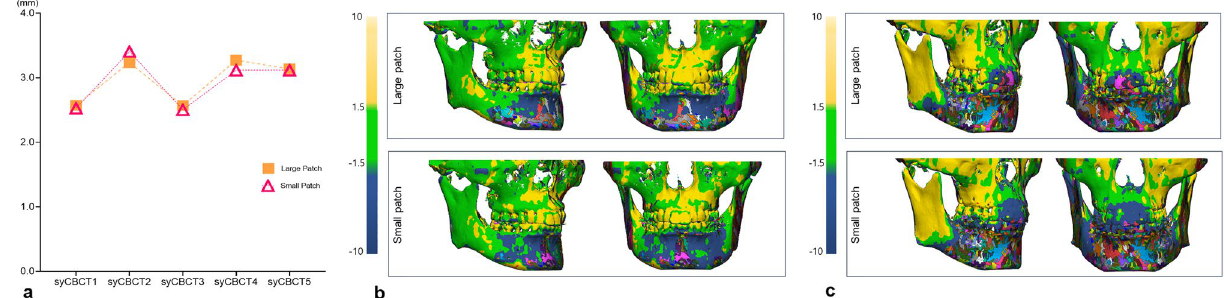
Figure 3. ( a ) The overall surface deviation of three-dimensional models ranged from 2.5 to 3.4 mm. ( b ) Surface deviation color maps in 3D models showing the smallest deviation (syCBCT 3). ( c ) Surface deviation color maps in 3D models show the largest deviation (syCBCT 2). CBCT, cone-beam computed tomography; syCBCT, synthetic